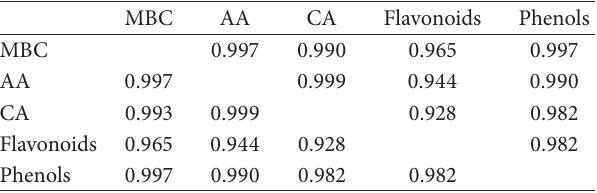
Table 4: Correlation between the results obtained in this